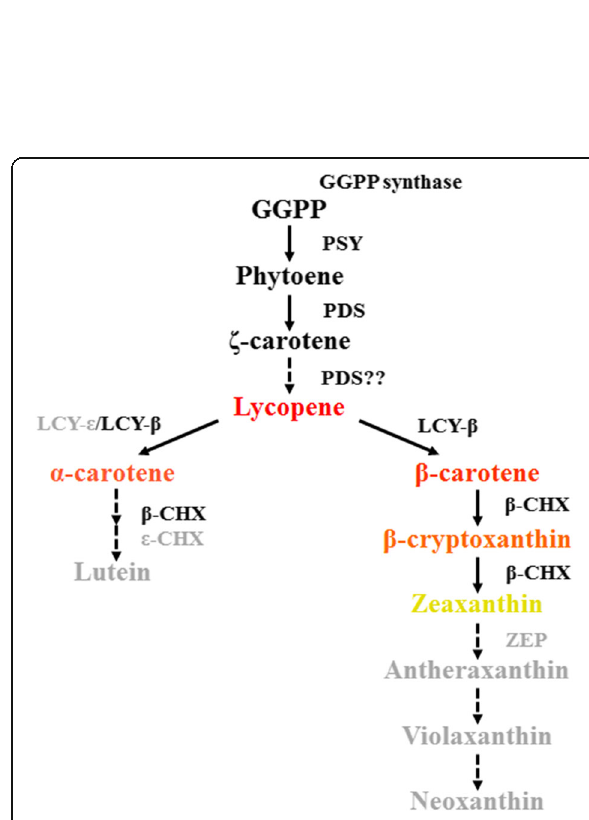
Fig. 5 Carotenoid biosynthesis pathway in K. konosiri X49 T . GGPP synthase, geranylgeranyl diphosphate synthase; PSY, phytoene synthase; PDS, phytoene desaturase; LCY- β , lycopene beta-cyclase;